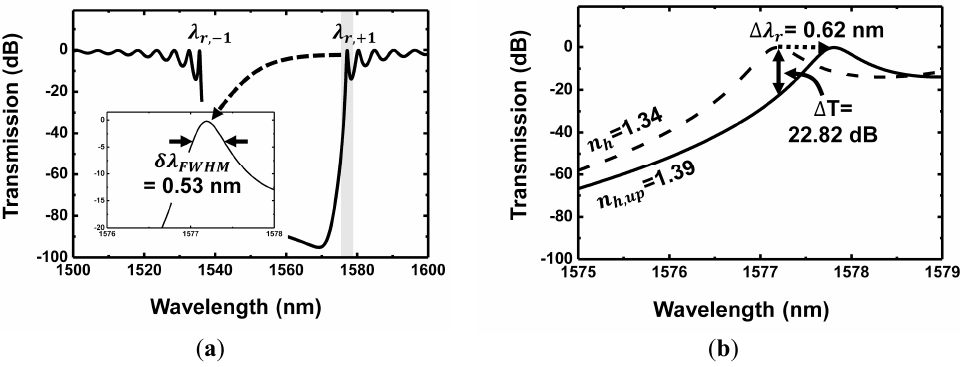
Figure 3. ( a ) Transmission spectrum of a grating waveguide showing the stopband and narrow FWHM δλ FWHM at λ r , + 1 ; ( b ) comparison of transmission spectra showing a resonance wavelength shift due to change in RI of the target layer before/after bio-interaction. (dashed curve: before multivalent binding ( n h = 1.34), solid curve: after multivalent binding ( n h = 1.34, n h , up = 1.39)), ∆ λ r : resonance wavelength shift, ∆T : transmission extinction.